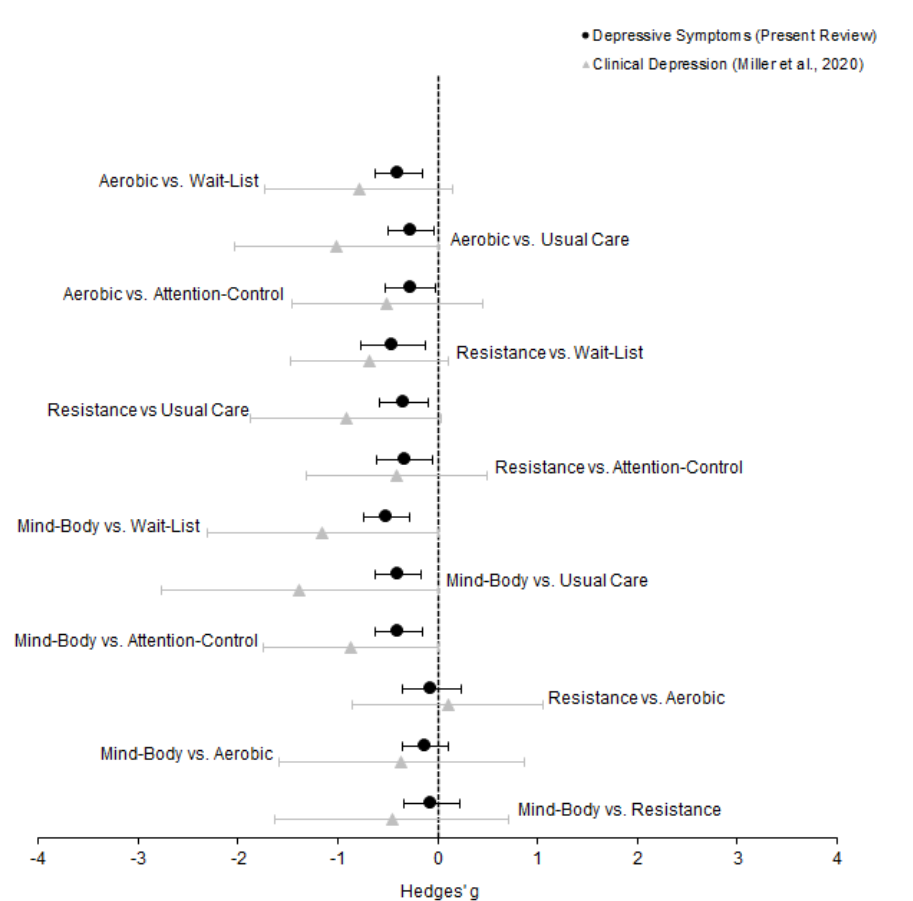
Figure 7. Forest plot depicting juxtaposed collective RCT evidence of older adults ( n = 5,975) in the depressive symptoms network. Circles represent the difference in the effect size estimate (Hedges’ g ) for those with depressive symptomology but not diagnosed with clinical depression ( n = 5,379). Triangles represent the difference in the effect size estimate (Hedges’ g ) for those with clinical depression ( n = 596; effect sizes adapted from Miller et al. , 2020). Horizontal lines represent the confidence intervals (95% CI ). The dotted vertical line represents the null hypothesis (Hedges’ g = 0). Negative scores indicate a greater decrease in depressive symptoms for the left group, and vice